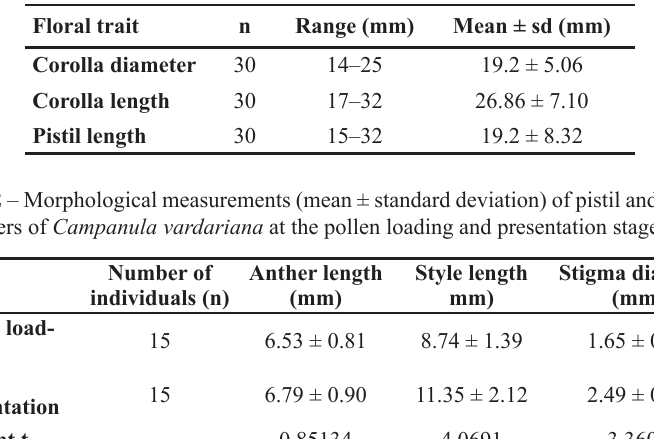
Table 1 – Floral morphology of Campanula vardariana .